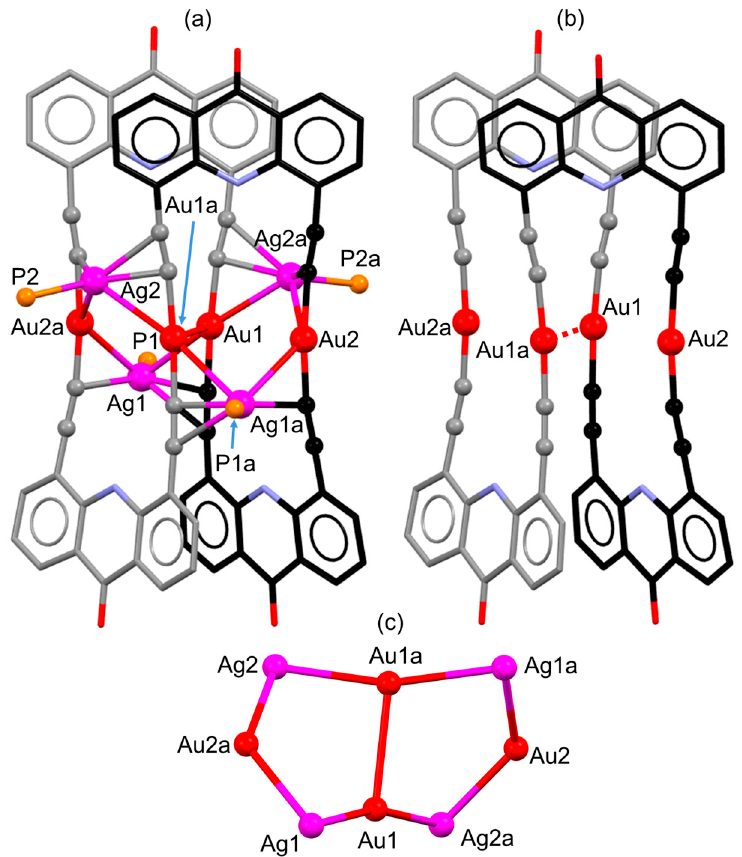
Figure 1. ( a ) A perspective view of Au 4 Ag 4 complex 1 plotted from X-ray crystallography. The hydrogen atoms and tert -butyl groups together with the phenyl rings on phosphorous atoms were omitted for clarity. ( b ) A view showing a twisted paper clip structure of Au 4 L 4 framework formed by gold(I)-bis(acetylide) σ -coordination. ( c ) A view of Au 4 Ag 4 cluster showing intermetallic contacts.